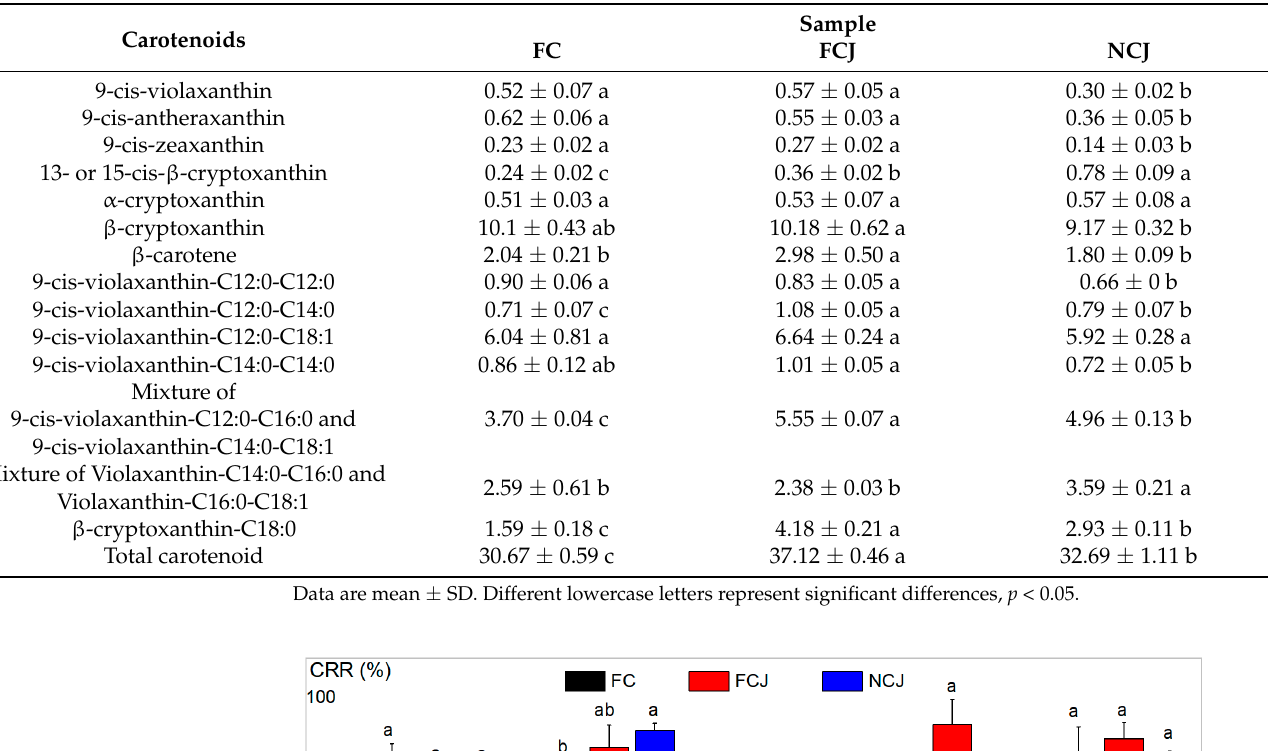
Table 2. Carotenoid retention in the small intestine of fresh citrus (FC), fresh citrus juice (FCJ), and not-from-concentrate citrus juice (NCJ) ( µ g/g).